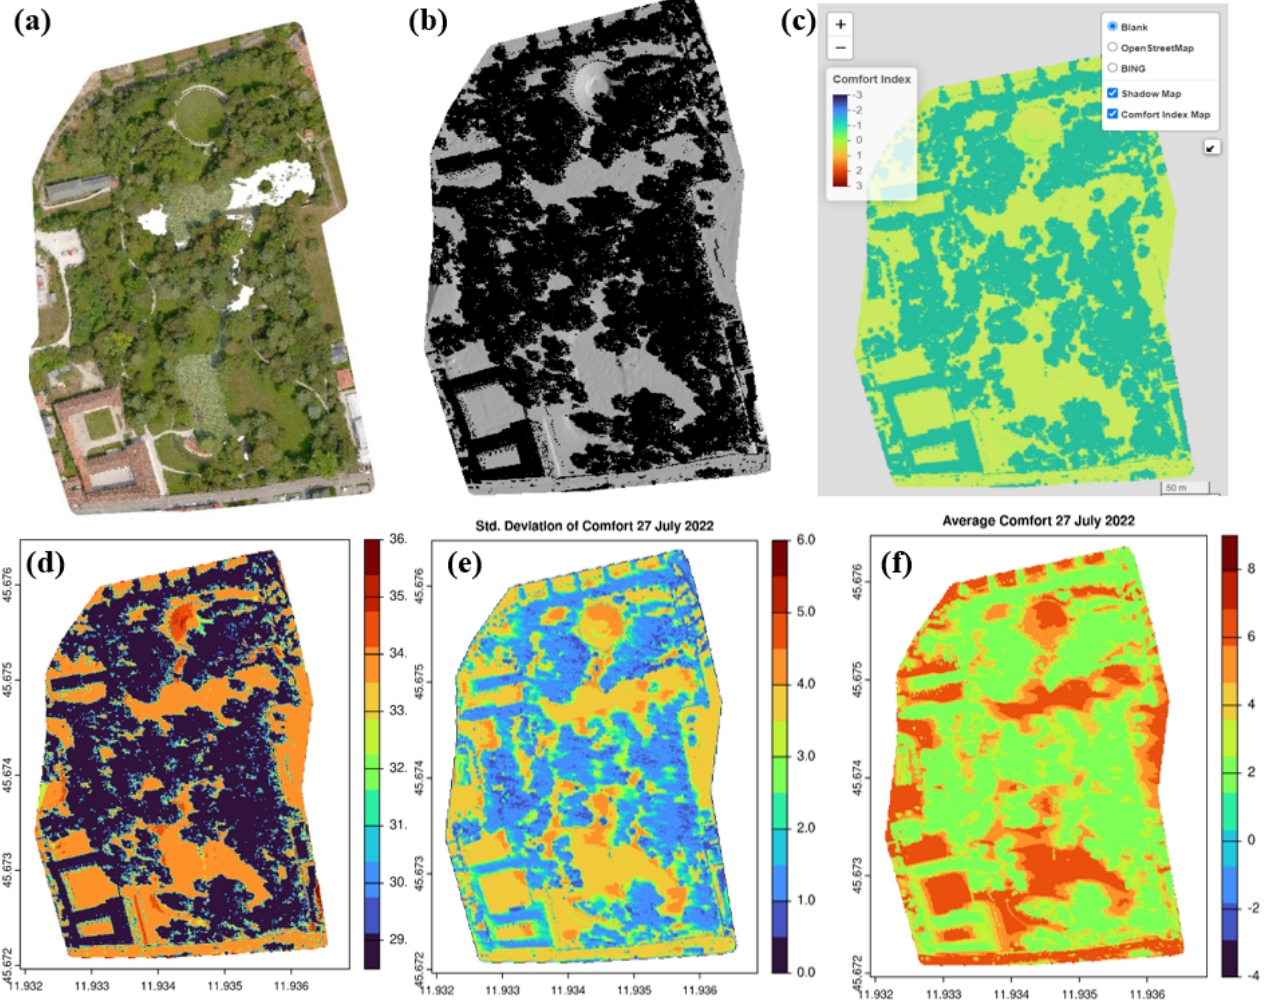
Figure 7. ( a ) overview of the historical garden from the LiDAR point cloud and photogrammetry for color information, ( b ) shadow simulation from the day 27 July 2022 at 09:56 a.m. local time, ( c ) map of comfort index values in 10 May 11:00 a.m.; ( d ) map of PET comfort index values 27 July 2022 at 09:56 a.m. local time, ( e ) standard deviation and average ( f ) of comfort index over the whole day of 27 July 2022 only during the daytime. All images are oriented to the geographic north.